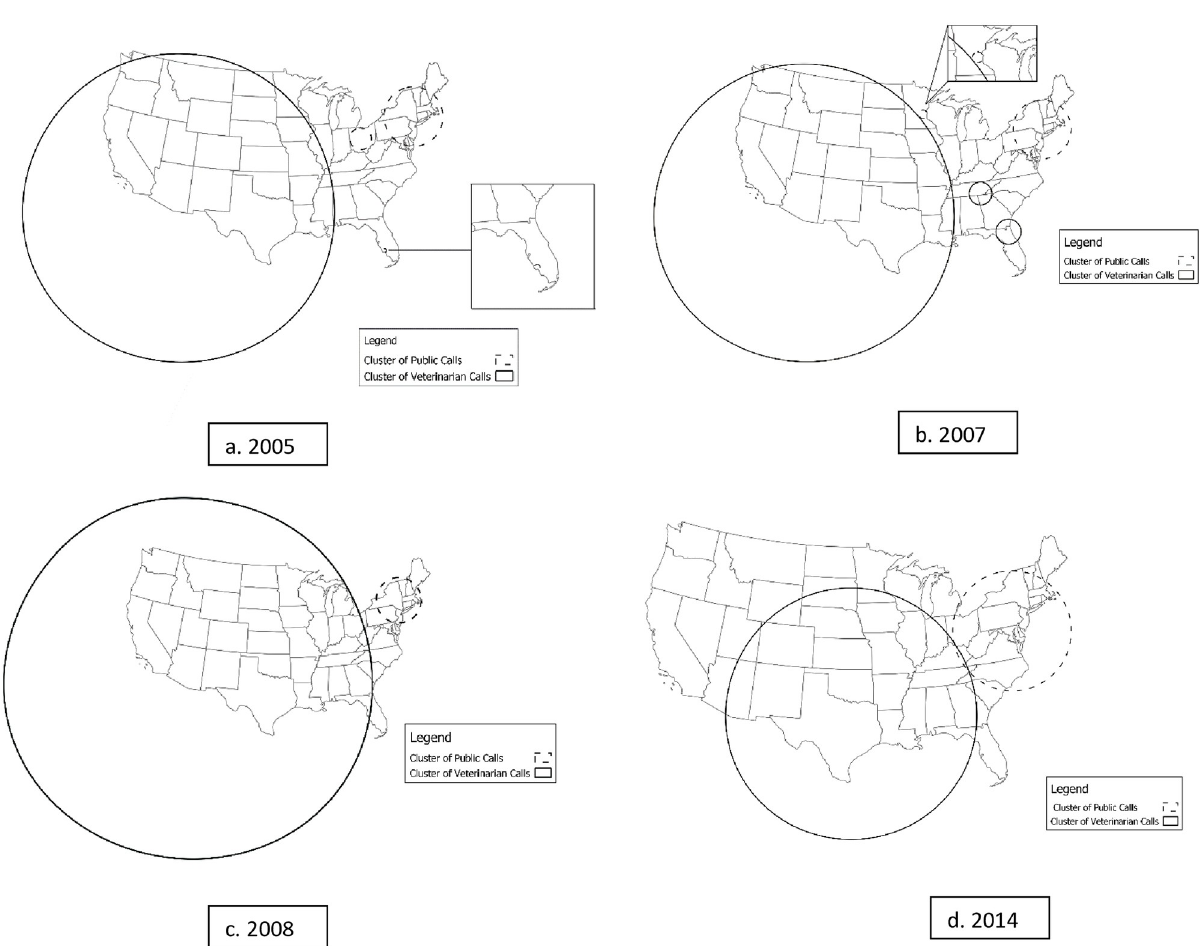
Fig 3. Examples of patterns identified in purely spatial scans of individual years: 2005, 2007, 2008, 2014, clusters with solid lines represent higher than expected veterinarian calls and dashed clusters represent higher than expected public calls.